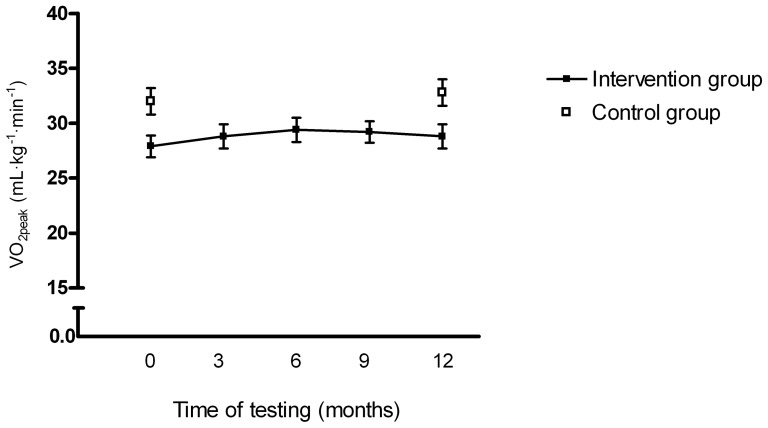
Peak oxygen uptake in the intervention group at baseline, after 3, 6 and 9 months, and at follow-up, and peak oxygen uptake in the control group at baseline and follow-up.The bars represent ± standard error of mean.